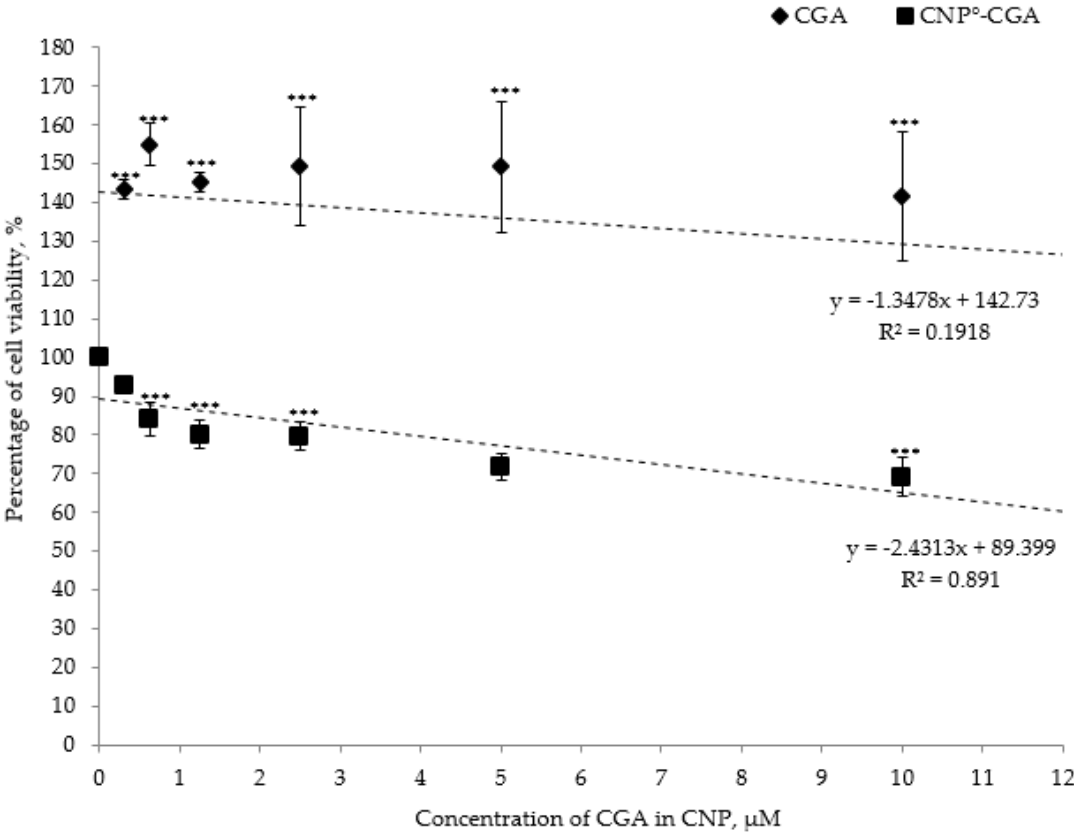
Figure 13. In vitro cytotoxicity test of CGA and CNP ◦ -CGA at di ff erent concentrations. Error bars represent the SD of three independent replicates of the experiment. CGA alone was found to be non-toxic even at its highest dosage of 12 µ M (24 h post-treatment). Conversely, a noticeable dose-dependent decrease in 786-O cell viability were observed upon encapsulation of CGA in CNP ◦ . * shows degree of significant di ff erence, p < 0.0001 compared to control.